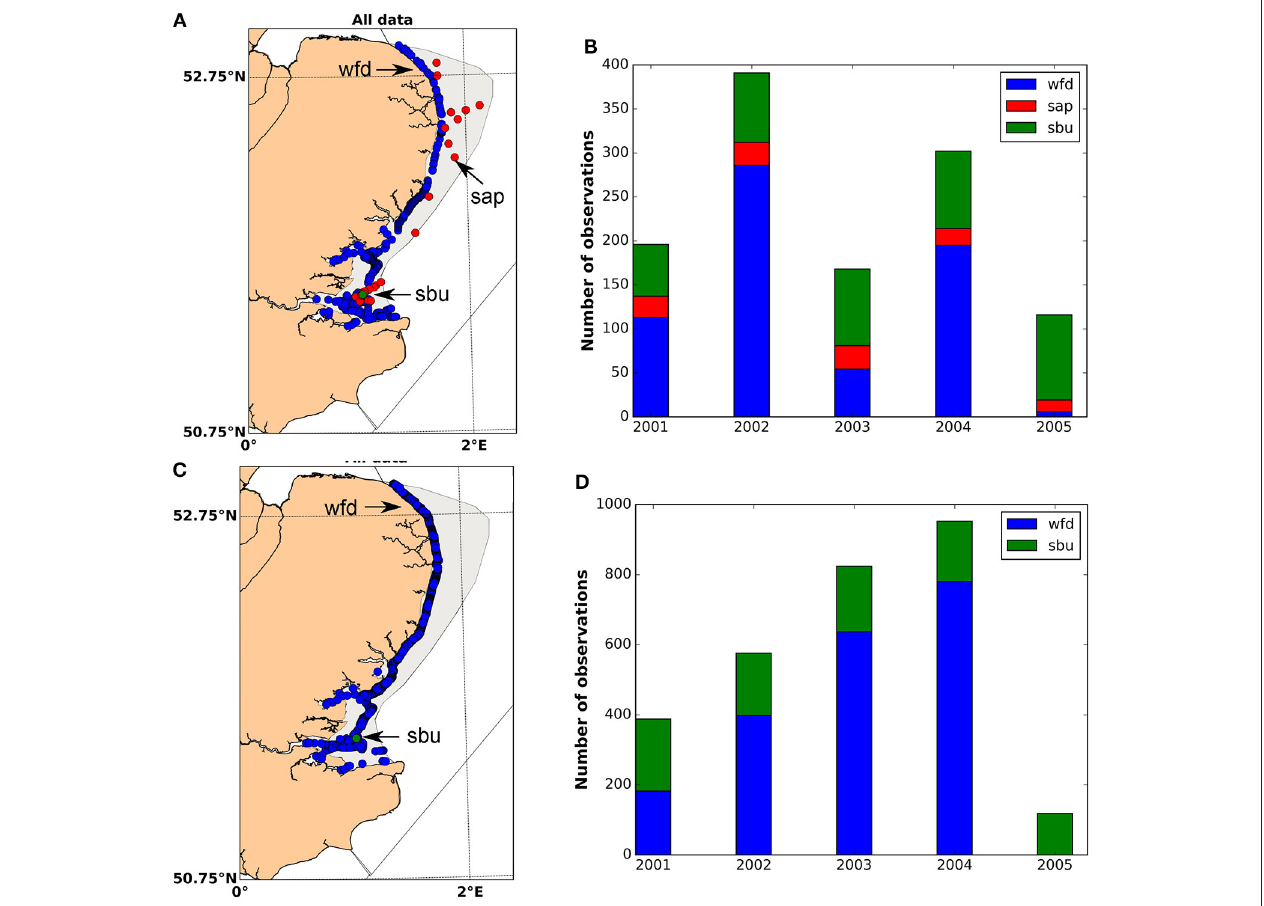
FIGURE 2 | Datasets for the DIN and chlorophyll assessment of East Anglia (COMP2). (A) Spatial distribution of DIN observations. (B) Temporal distribution of DIN observations per year and dataset. (C) Spatial distribution for chlorophyll observations and (D) temporal distribution of chlorophyll observations per year and